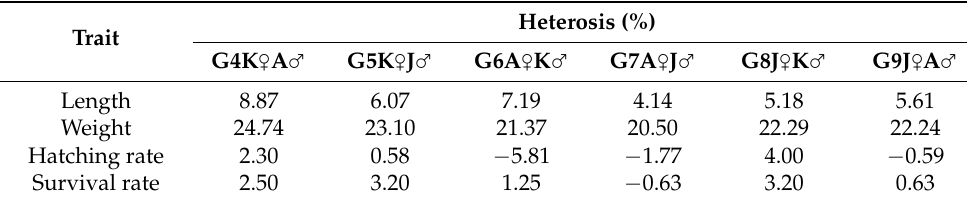
Table 5. Heterosis for total length (TL), body weight, hatching and survival rate in six cross breed groups of Ariza labeo ( L. ariza ). The single words picked to name the purebred and crossbred groups bear the full forms as G → Group, K → Kangsha River stock, J → Jamuna River stock and A → Atrai River stock.